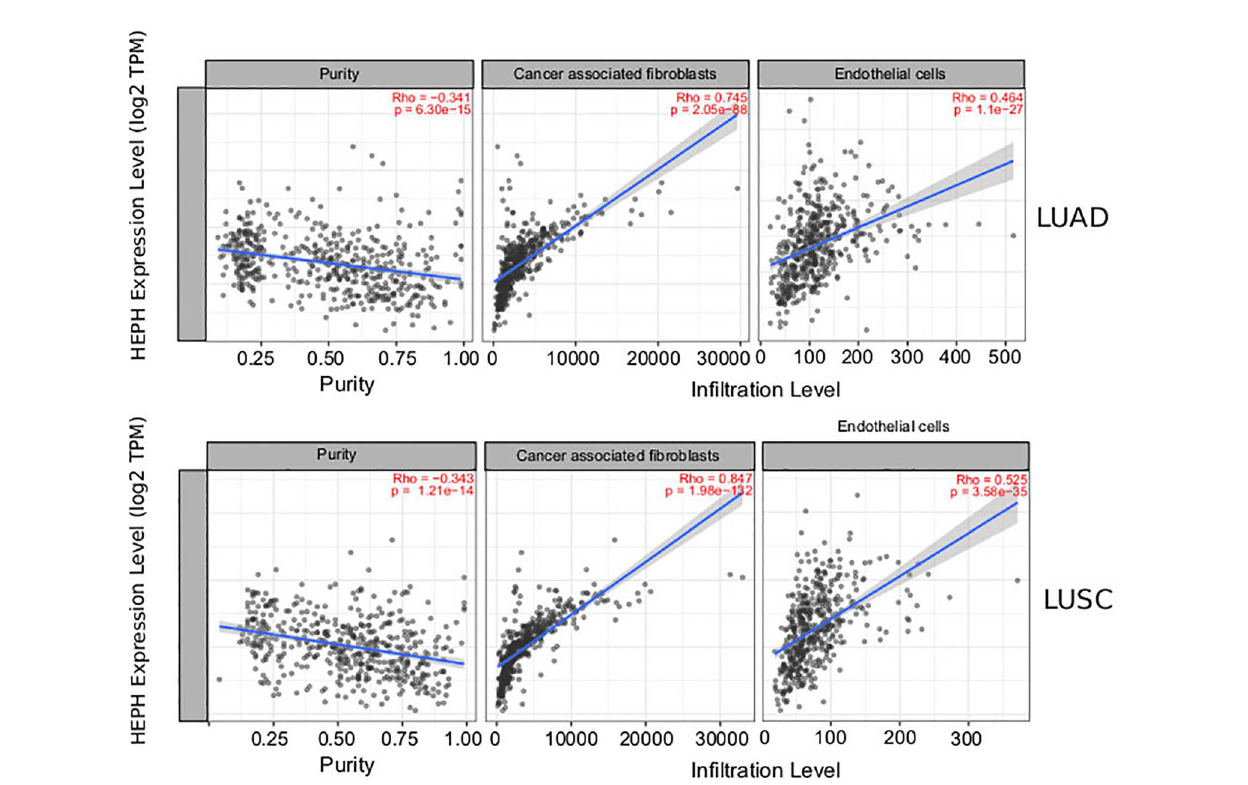
FIGURE 2 | Correlation of HEPH expression with in fi ltration level of non-immune cells in LUAD and LUSC. HEPH expression is signi fi cantly negatively correlated to tumor purity and has signi fi cant positive correlations with the in fi ltrating levels of cancer-associated fi broblasts and endothelial cells.